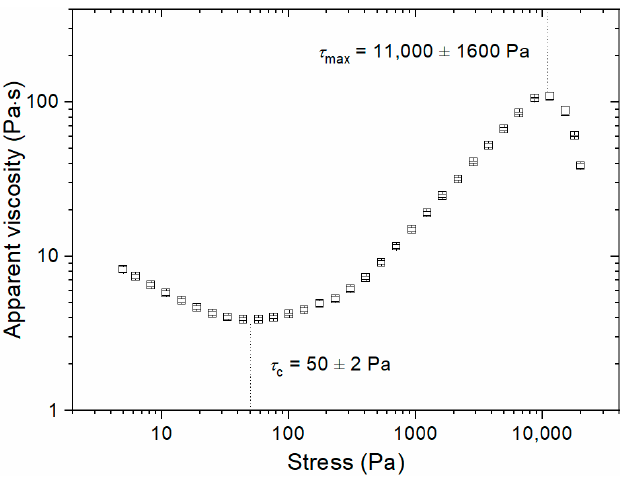
Figure 4. Variation of steady apparent viscosity with shear stress of the R816/PPG400 suspension. As it was pointed out before, the description of the viscous behavior of time-dependent fluids has been done in terms of the evolution of the internal microstructure that forms with the shear flow [5]. It is reasonable to expect that different structural levels be are achieved depending on the shear intensity. Cheng [40] proposed a rheological method to compare the microstructure strength achieved by the fluid at different shear stress values. As it is shown in Figure 5, Cheng’s method consists of applying consecutive step changes in stress from an equilibrium state ( τ eq ) to different stress values ( τ k , k = 1, . . . , n) and recording the peak values in viscosity ( η k , k = 1, . . . , n). In this way, the steady microstructure corresponding to different τ eq -values can be characterized. Each step must be applied just after the same reference steady viscosity value ( η eq ) is reached. In this way, initial viscosity values ( η k ) corresponding to each τ k refer to the same internal structure, which is formed when the steady state is achieved from the application of τ eq . Therefore, a series of different constant structure curves can be obtained by plotting η k versus τ k for several τ eq -values. Constant structure curves overlap when suspensions are non-aggregated. On the contrary, the dependence of the viscosity peak values with τ eq is an indication of the existence of aggregates